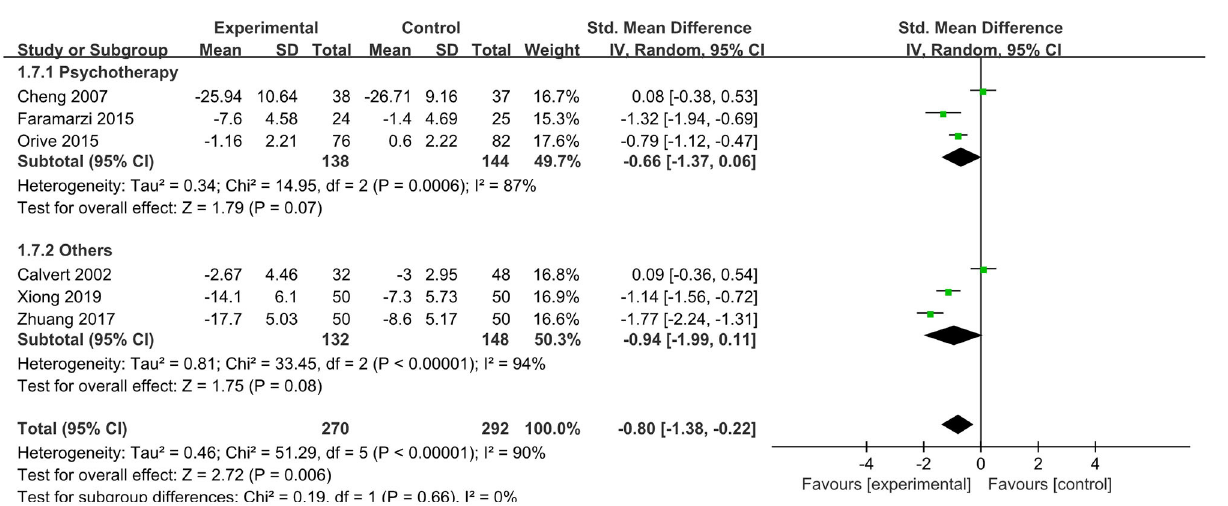
FIGURE 6 | Meta-analysis of the effect of psychological interventions on anxiety. CI, confidence interval; Others, hypnotherapy/cognitive behavioral therapy/relaxation therapy.